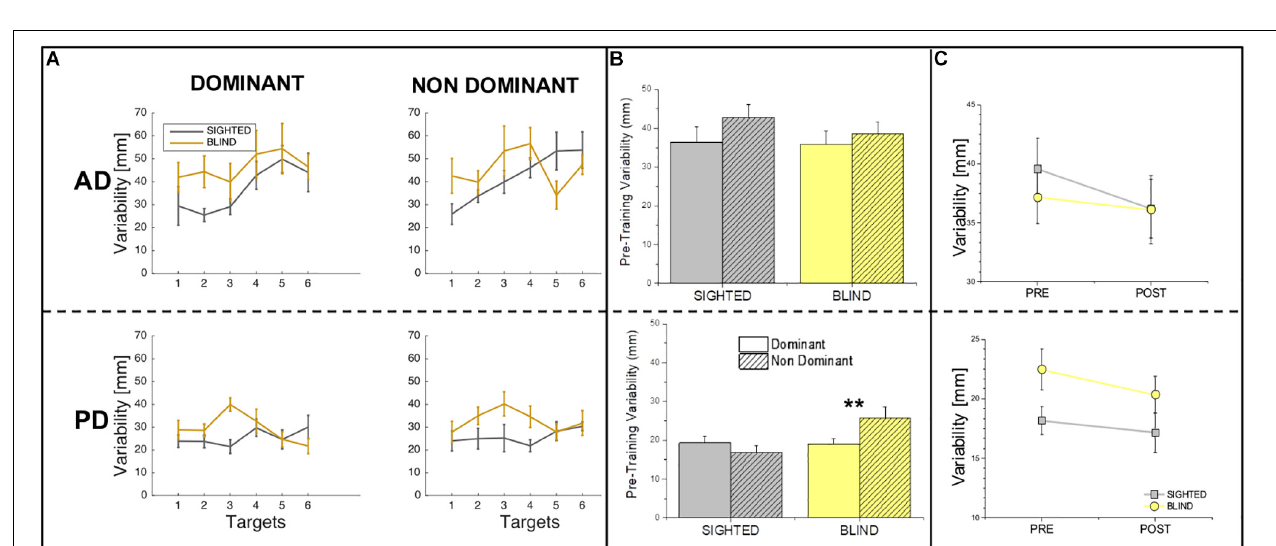
FIGURE 3 | Variability in the auditory and proprioceptive domains. (A) The panel represents the auditory (top) and proprioceptive (bottom) variability (in mm) for the dominant (left) and non-dominant (right) arms. Results are shown for each target location and indicate that for both the auditory and proprioceptive domain, variability is target location independent for both groups. (B) The panel represents the auditory (top) and proprioceptive (bottom) variability (in mm) at the pre-training session for the dominant (plain bars) and non-dominant (pattern bars) arms. Results indicate that for each group, there is not difference in terms of variability between the dominant and non-dominant sides across domains with the only exception for blind participant in the Proprioceptive domain, who present a higher variability on the non-dominant hand. (C) The panel represents the comparison of variability (mm) in the pre-training and post-training sessions across sides (dominant and non-dominant pulled together) in the auditory (top) and proprioceptive (bottom). Results indicate that for both auditory and proprioceptive domains, variability does not change from the pre-training to the post-training session neither for the sighted nor for the blind participants. ∗∗ Indicates p -values < 0.01.